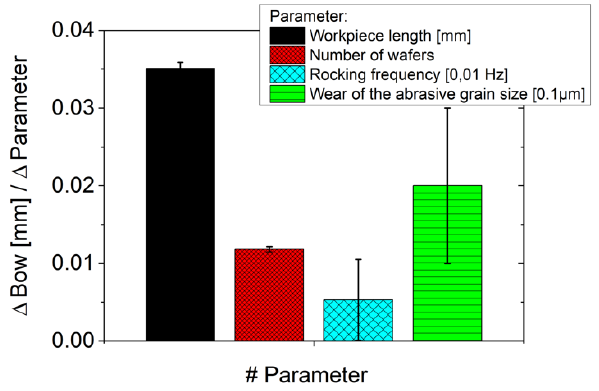
Figure 15. Variation of different sawing parameters and their influence on the increase of the bow.